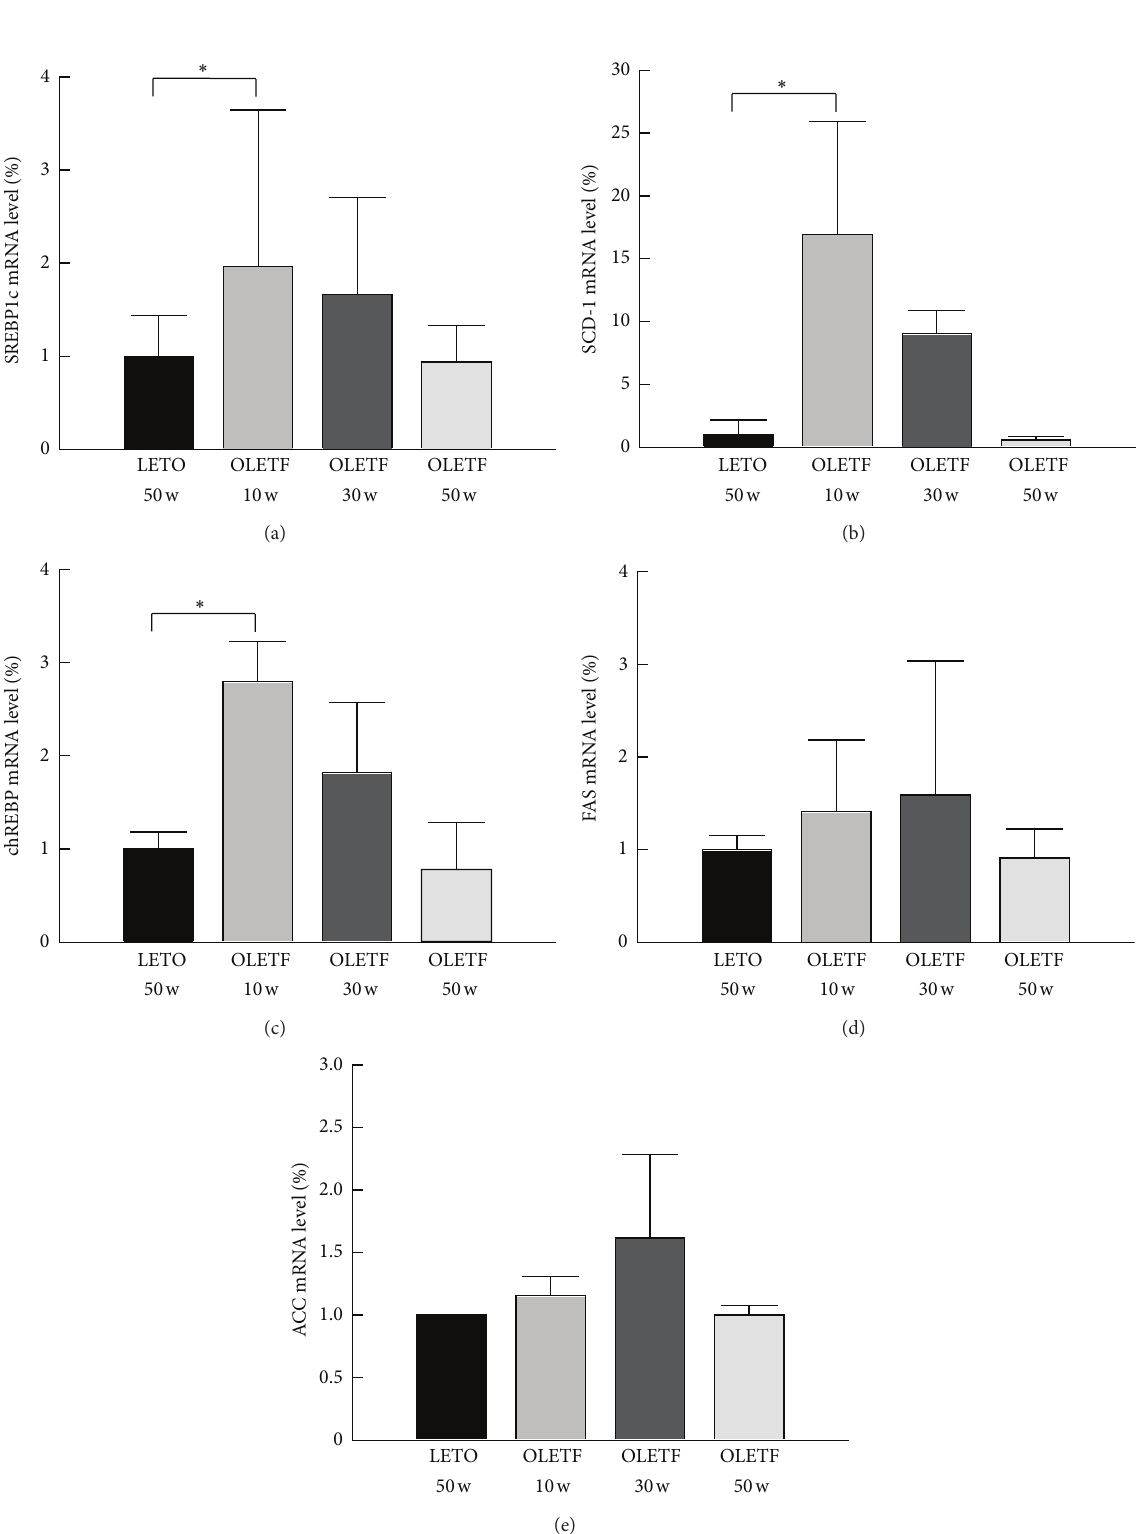
Figure 4: Expression of genes related to lipogenesis. Levels of SREBP-1c, SCD-1, chREBP, FAS, and ACC mRNA in the liver at 10, 30, and 50 weeksofage.((a)–(e))Sterolregulatoryelement-bindingprotein(SREBP)1c,stearoyl-CoA-(SCD-)1,carbohydrateresponseelement-binding protein (chREBP), fatty acid synthase (FAS), and acetyl-CoA carboxylase (ACC) mRNA levels, respectively. Mean values were obtained from livers of 3 separate animals. Polymerase chain reactions performed in duplicate. The transcript levels normalized relative to GAPDH expression. Data are expressed as means ± SD. ∗ 𝑃 < 0.05 compared with LETO